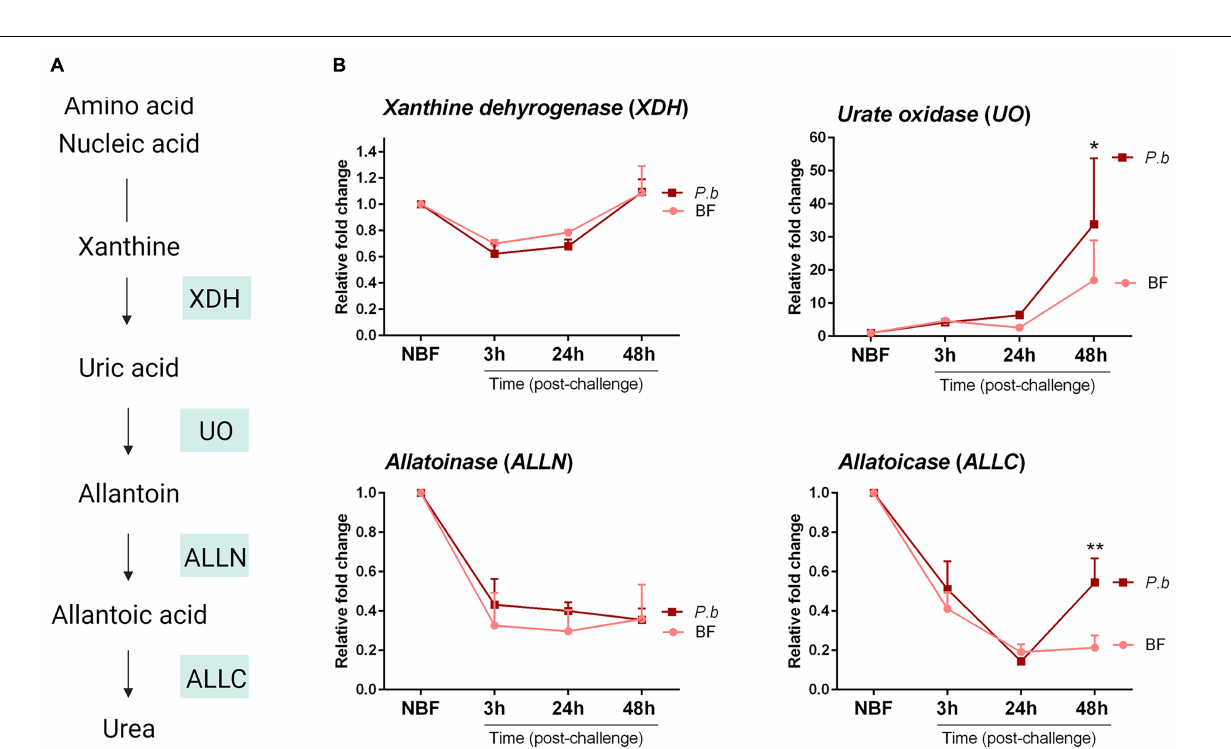
FIGURE 2 | Gene expression analysis of uricolytic pathway enzymes following blood-feeding and P. berghei infection. (A) Overview of the intermediates and enzymes involved in nitrogen metabolism of amino acids and nucleic acids into urea. Genes encoding key enzymes: xanthine dehydrogenase ( XDH ), urate oxidase ( UO ), allatoinase ( ALLN ), and allatoicase ( ALLC ), are shown in shaded boxes. (B) Gene expression analysis of XDH , UO, ALLN, and ALLC under sugar-fed (NBF) conditions or 3, 24, and 48 h after feeding on a naïve or P. berghei -infected blood meal. Data from three independent experiments are displayed as the mean ± SEM and were analyzed using a two-way repeated-measures ANOVA followed by Sidak’s multiple comparison to determine significant differences. Asterisks denote significance (* P < 0.05, ** P < 0.01). Data analysis was performed using GraphPad Prism 7.